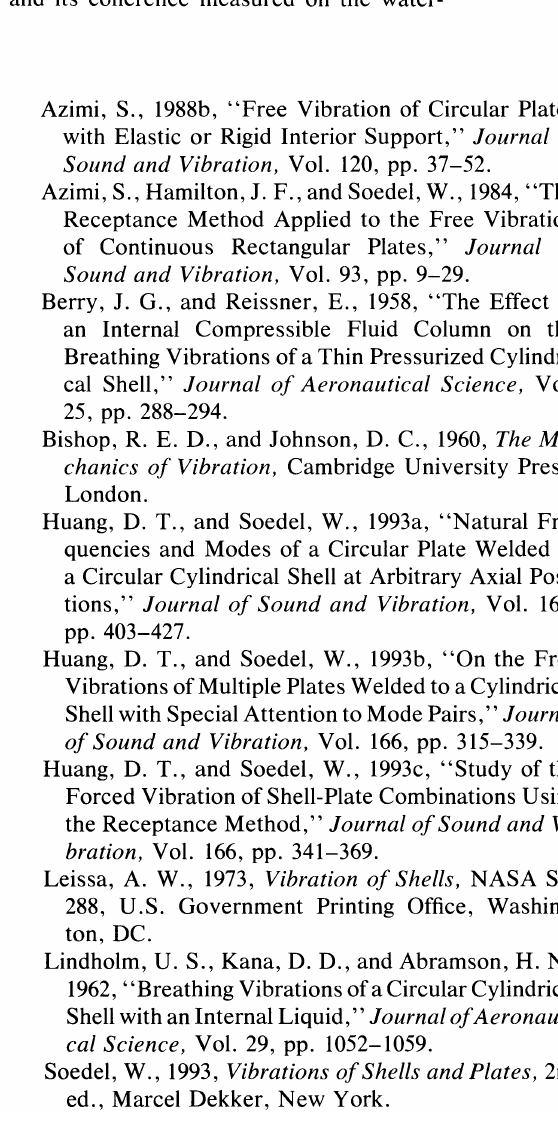
FIGURE 6 Experimental FRF (amplitude) and its coherence measured on the water filled shell with the lumped mass